Question: What form of chart is displayed?
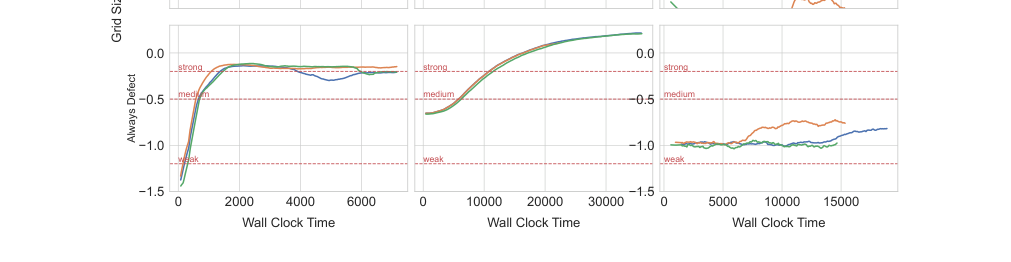
Answer: line